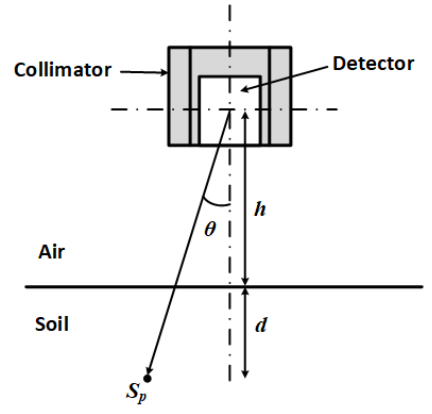
Figure 1. Geometry and parameters for estimating the flux (measured by the detector) due to the point source S p in the